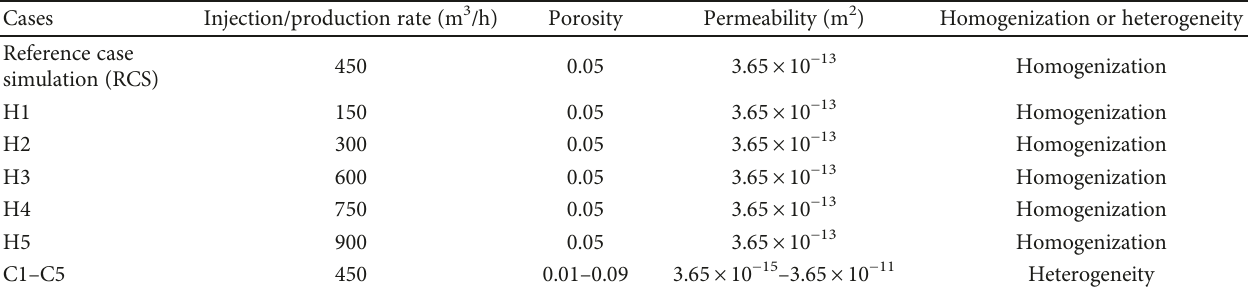
Table 5: Parameter setting of the modeling cases.